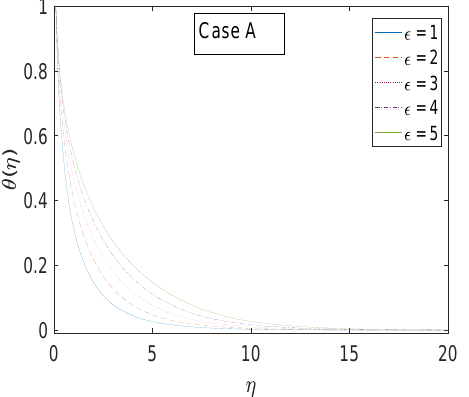
Figure 5. Temperature profiles for different values of parameter 𝜖 when λ = 0.8, Pr = 5, m = 0.1 and θ w = 1.27.